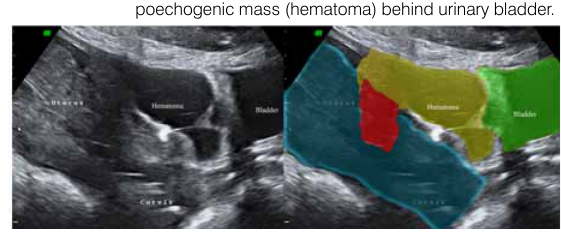
Figure 4. Bladder flap hematoma 96 hours after Cesarean section. The midsagittal plane of the pelvis showing large hy- poechogenic mass (hematoma) behind urinary bladder.